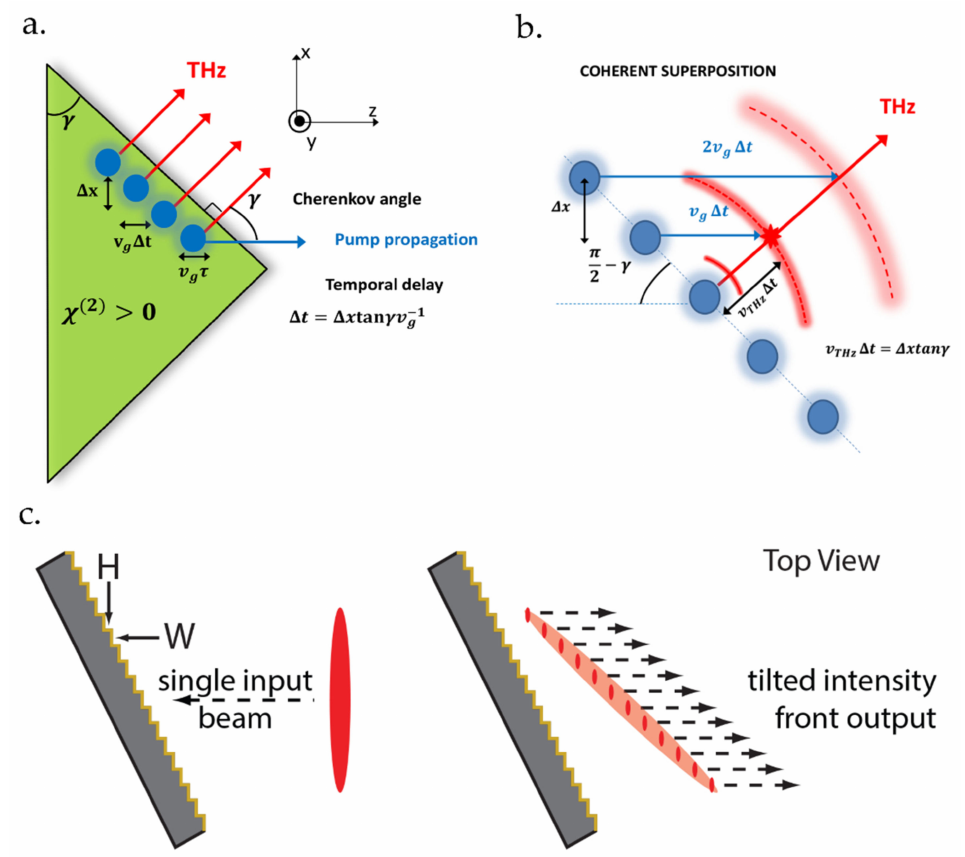
Figure 5. Phase matching condition for beamlet superposition and methods to generate a discrete TPF. ( a ) The beamlets have a pulse duration τ , transverse separation distance ∆ x , and delay between beamlets ∆ t . ( b ) The superposition of the neighboring beamlets exists if ∆ x < σ . The strong divergence prevents the superposition with further beamlets. ( c ) When the pump laser is incident on the reflective echelon, the beamlets are generated with a discrete TPF. The height H and width W of the echelon steps give the tilt angle θ = tan − 1 2 H . Considering the demagnification factor W M of the lenses and the refractive index n gr of LN, the tilt angle in the crystal further becomes NIR γ = tan − 1 2 HM . [Reprinted/Adapted] with permission from [75,76], © The Optical Wn gr NIR